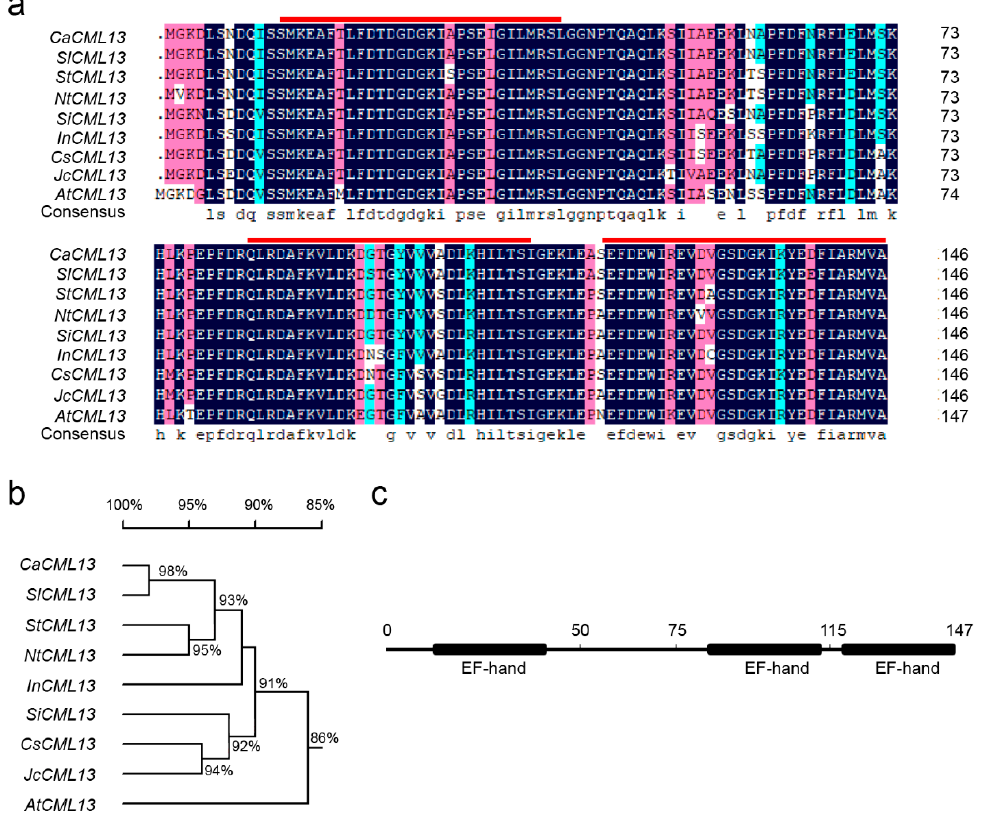
Figure 2. Deduced amino acid sequence of pepper CaCML13 and its sequence similarities to its orthologs in other plant species. ( a ) Comparison of deduced amino acid sequences of pepper CaCML13 to its orthologs in other plant species, amino acid residues that are conserved in at least five of the seven sequences are shaded, whereas amino acids identical in all seven proteins are shown in black, alignments were made in DNAMAN 7 (Lynnon Biosoft, USA) using the default parameters; ( b ) phylogenetic analysis of CaCML13 with its orthologs in other plant species including S. lycopersicum , S. tuberosum , N. tabacum , S. indicum , I. nil , J. curcas , C. sinensis and A. thaliana ; ( c ) highly conserved EF-hand motifs in CaCML13.